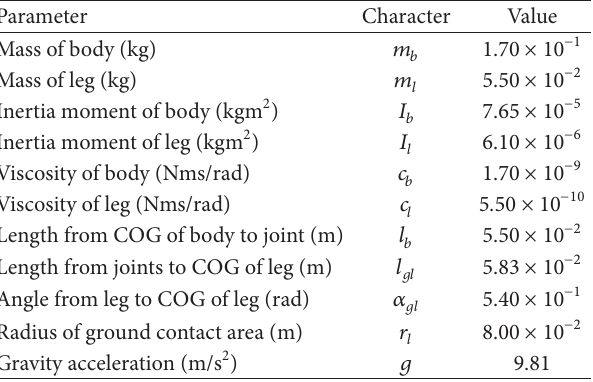
robot performs periodic rolling locomotion with energy- based control.